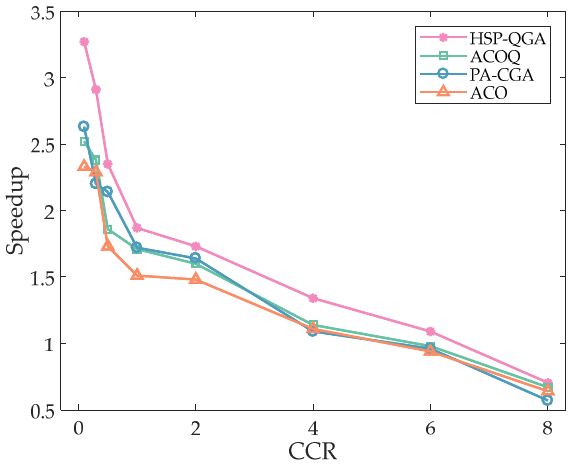
Figure 12. Effect of different CCRs on speedup.